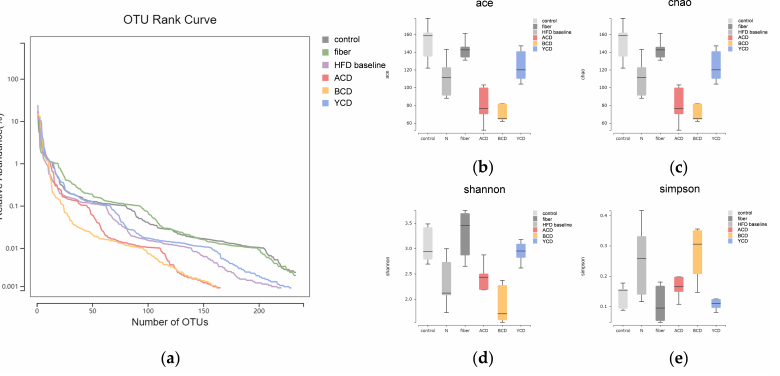
microbiome. ( a ) OTU rank curve; ( b ) Ace index; ( c ) Chao index; ( d ) Shannon index; ( e ) Simpson index. n = 6. Control, low ‐ fat diet; HFD baseline, high ‐ fat diet without cellulose; fiber, high ‐ fat diet; index. n = 6. Control, low-fat diet; HFD baseline, high-fat diet without cellulose; fiber, high-fat ACD, high ‐ fat diet that replaced α‐ CD with cellulose; BCD, high ‐ fat diet that replaced β‐ CD with